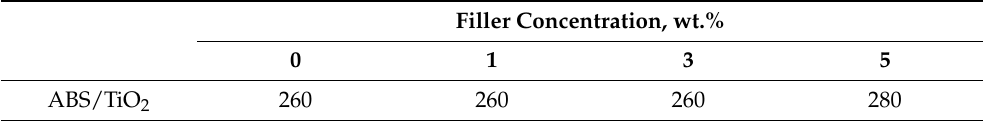
Table 3. Extrusion temperature for 3D filaments containing different TiO 2 concentrations. Filler Concentration,